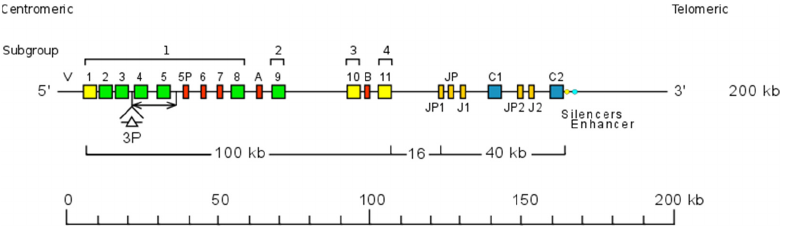
Figure 11. Representation of the human TRG locus at 7p14 (REV orientation on the chromosome) [3]. The boxes representing the genes are not to scale. Exons are not shown. A double arrow indicates an insertion/deletion polymorphism. The TRGV3P gene, a polymorphic gene by insertion has been identified by Southern hybridization in a rare haplotype but has not been sequenced. IMGT